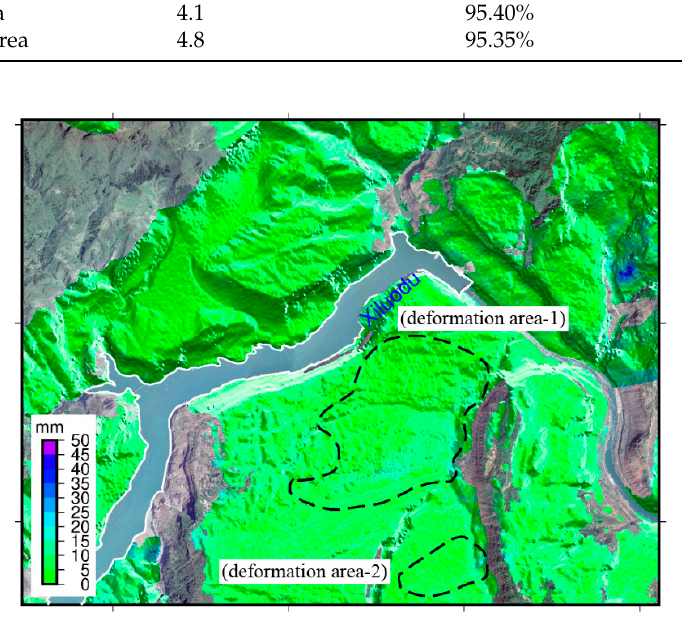
Figure 14. Overall root mean square error map. Table 2. RMS data statistics.